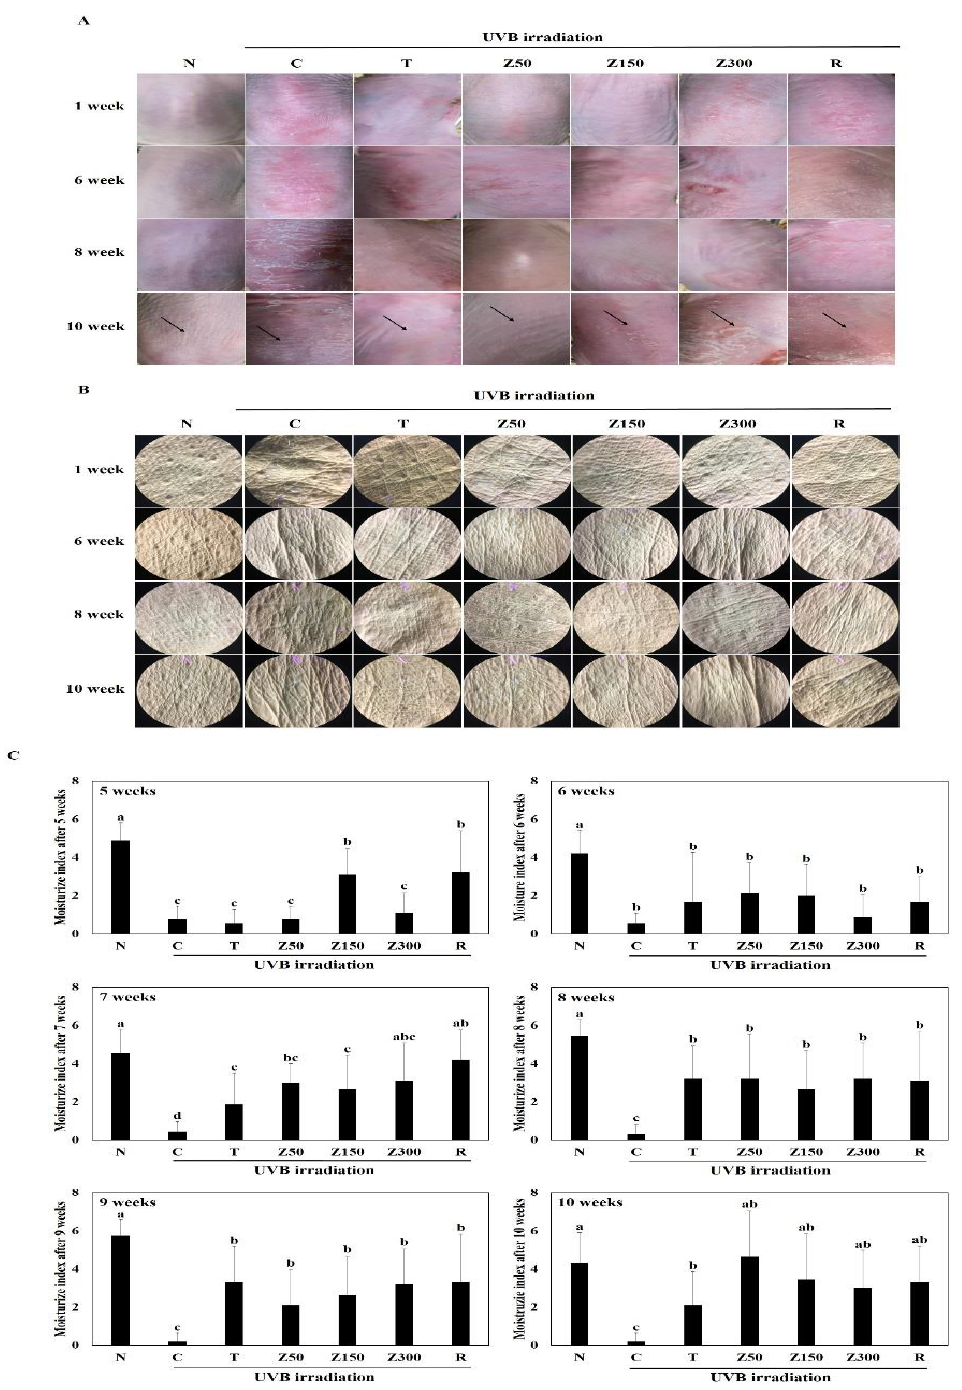
Figure 2. Effects of tricin or ETZL on wrinkle formation in UVB-irradiated SKH-1 hairless mice. ( A ) Microscopic morphological observations at 1, 6, 8, and 10 weeks; ( B ) Images of skin replicas using SILFLO at 1, 6, 8, and 10 weeks; ( C ) Effects on moisture contents at 5 to 10 weeks. Each bar represents the mean ± SD ( n = 9). N, normal control; C, UVB-irradiated control; T, tricin (0.3 mg/kg) oral administration with UVB irradiation; Z50, ETZL (50 mg/kg) oral administration with UVB irradiation; Z150, ETZL (150 mg/kg) oral administration with UVB irradiation; Z300, ETZL (300 mg/kg) oral administration with UVB irradiation; R, UVB irradiation with dermal application of 0.05% retinoic acid. Values are expressed as mean ± SD of nine mice. Different letters show a significant difference at p < 0.05 as determined by Duncan’s multiple range